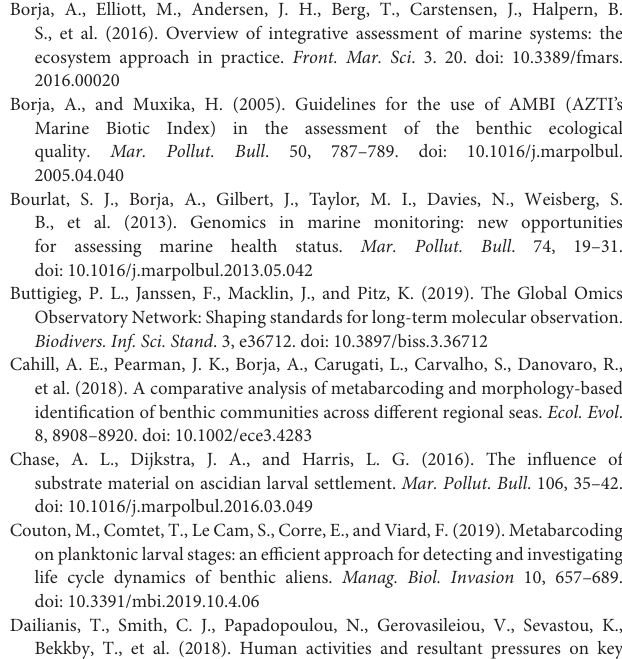
Supplementary Table 1 | Overview of observatories and sample events of the ARMS-MBON pilot phase. Supplementary Table 2 | Overview of genetic data generated during the ARMS-MBON pilot